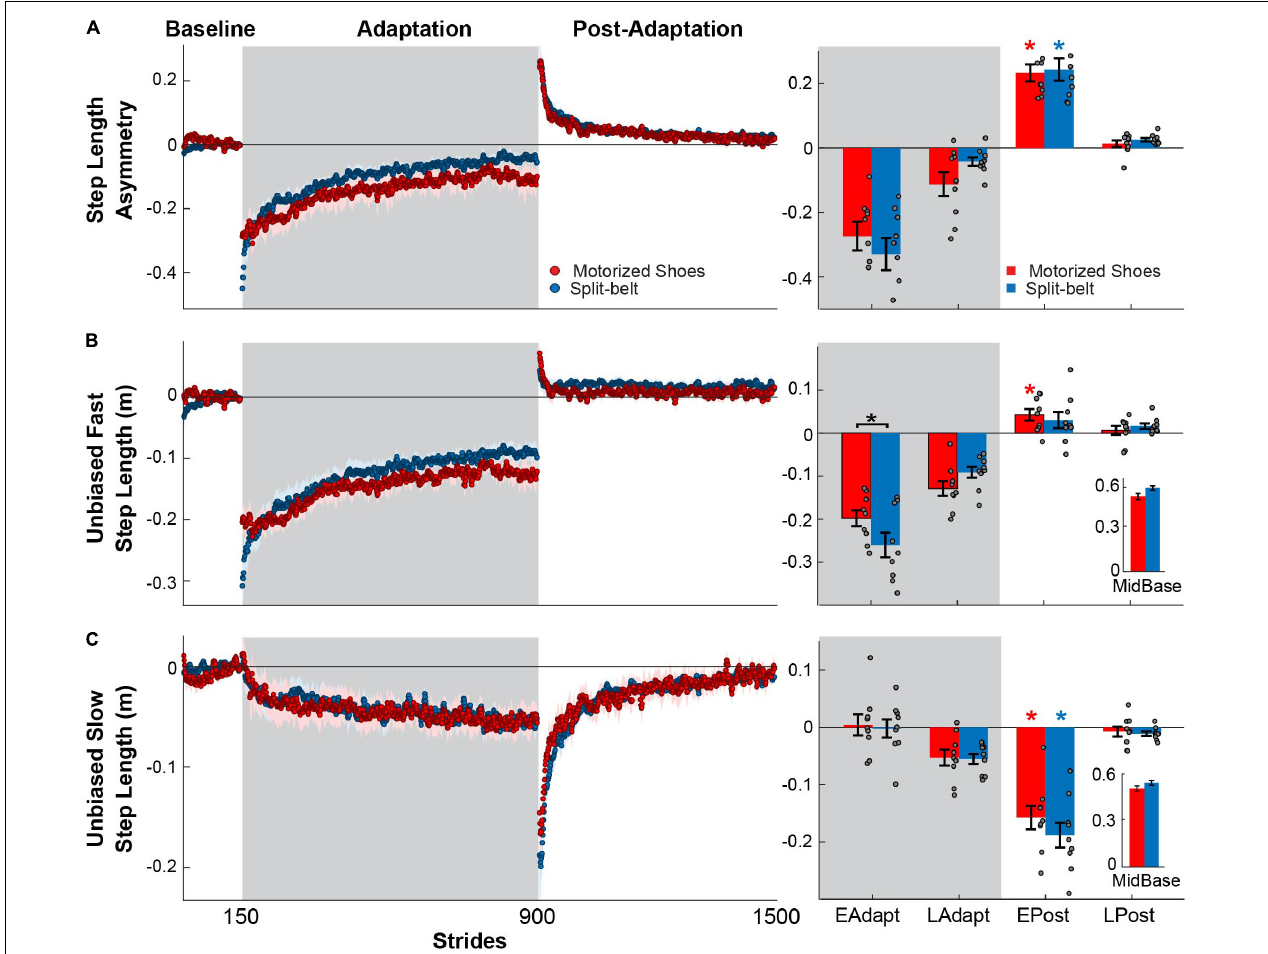
FIGURE 3 | Modulation of step length asymmetry and step lengths. ( A–C , Left panel) Time courses for step length asymmetry and individual step lengths during medium baseline, adaptation, and post-adaptation. Shaded gray area represents the adaptation period when the feet move at different speeds (“split” walking), whereas white areas represent when the feet move at the same speed. Colored dots represent the group average of five consecutive strides and colored shaded regions indicate the standard error for each group (motorized shoes: red; split-belt: blue). ( A–C , Right panel) Bar plots indicate the mean ± standard errors for step length asymmetry and step lengths for each group and epoch of interest. Note that the reported step lengths are unbiased. This was done by subtracting the averaged step length values during baseline at medium speed in each participant. Significant differences for post hoc tests were indicated as follows. Black asterisks over the bracket above each epoch represent statistical significant differences between the motorized shoes and the split-belt groups ( p < 0.05). Colored asterisks over the bars indicate significant after-effects (i.e. early post-adaptation is significantly different from baseline; p < 0.05) for each of the groups (motorized shoes: red; split-belt: blue). The small bar plots on the right indicate the mean ± standard errors for the step lengths for each group during medium